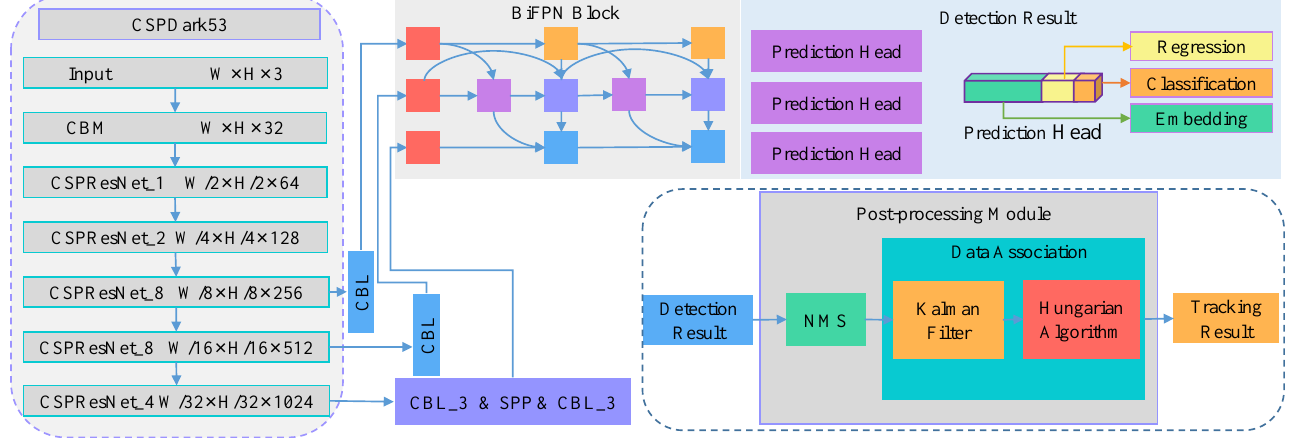
Figure 1. The whole structure of the algorithm consists of a detection module and a post- processing